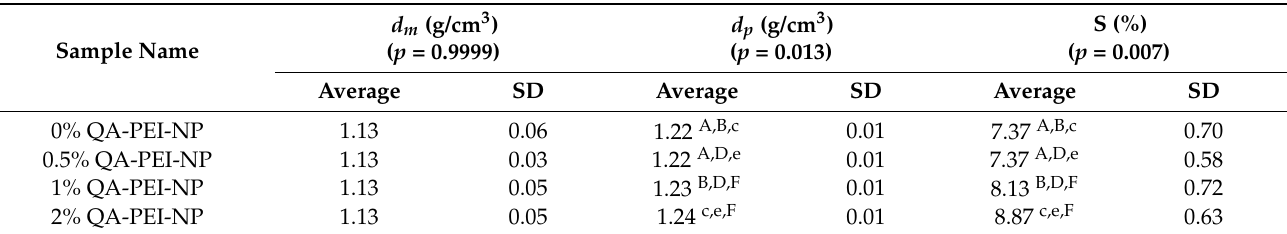
Table 1. The monomer density ( d m ), polymer density ( d p ), and polymerization shrinkage (S) of studied materials. Statistically significant differences ( p ≤ 0.05) are marked with the lower case letters, whereas statistically insignificant differences ( p > 0.05) are marked with the upper case letters.